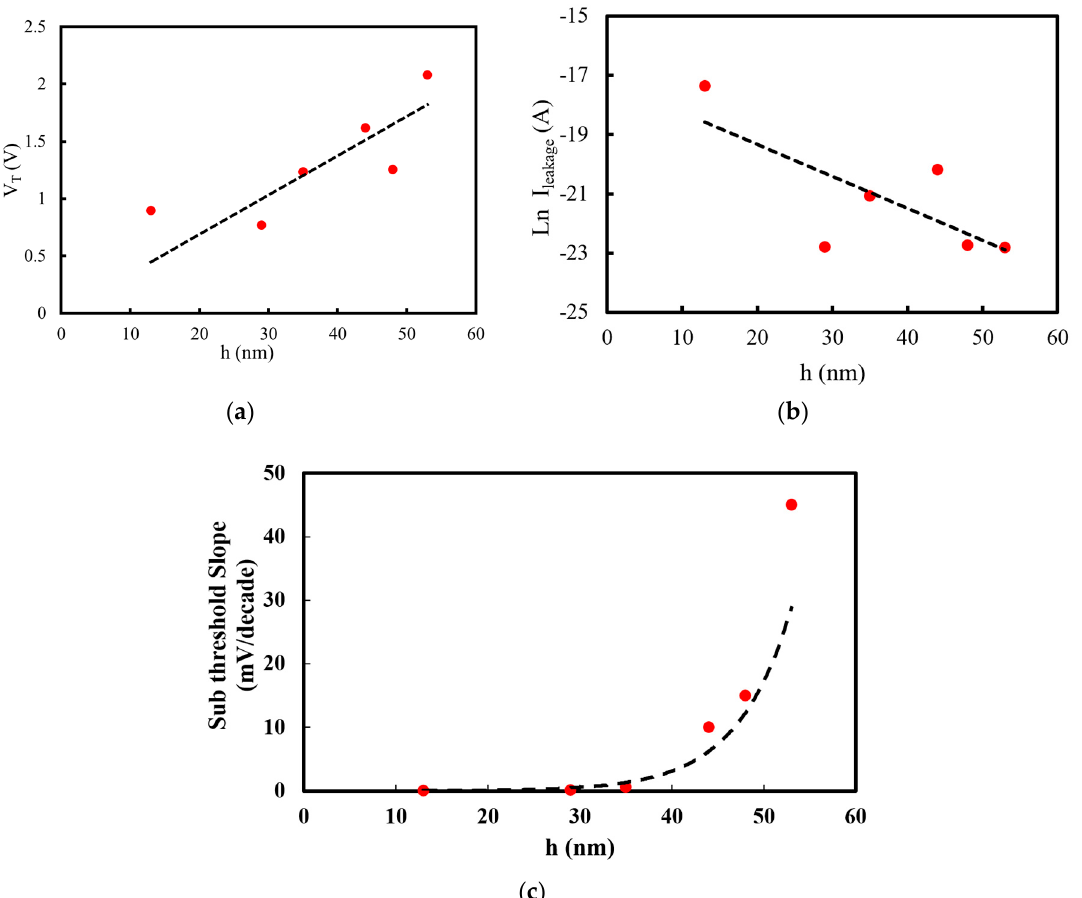
Figure 3. ( a ) V T , ( b ) I leakage and ( c ) switching current slope (S c ) as a function of VO 2 nanoparticle size. The values of V T and leakage currents were taken from the I-V curves of Figure